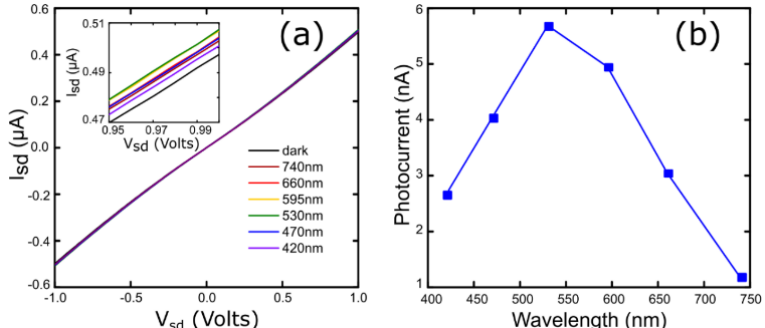
Figure 6. ( a ) I sd -V sd curves for different illumination wavelengths and V g = 0 V. Inset shows a smaller